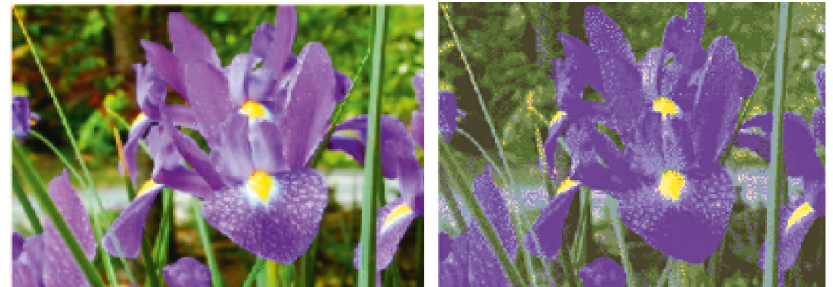
Figure 3: Schematic diagram of image conversion.